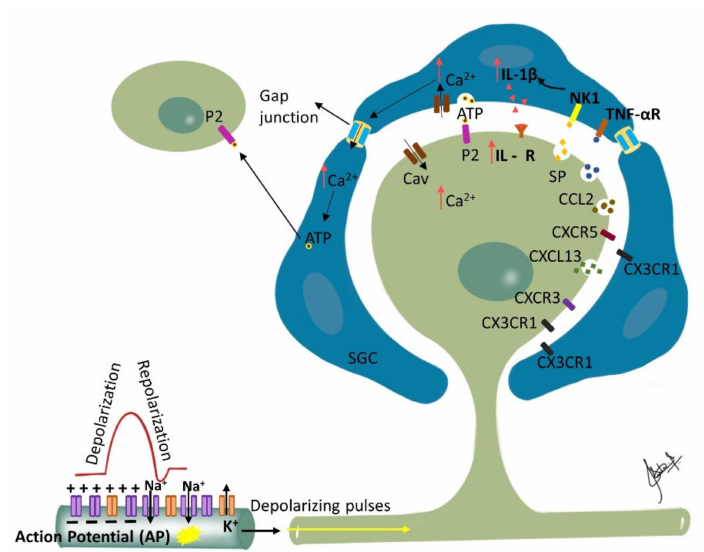
Figure 2. Ganglionic Sensitization: Changes associated with trigeminal nerve injury or inflammation lead to alterations in the cell bodies in the trigeminal ganglion (TG) that start to release pronociceptive substances. Satellite glial cells (SGC) surrounding the TG become activated in the presence of periph- eral inflammation that leads to enhanced production and subsequent activation of neurokinin 1 (NK1) receptors with the SP released from the TG nociceptor. Activated SGC produce proinflammatory cytokines (IL-1 β , TNF- α ) that bind to their receptors on the nociceptor contributing to inflammatory hyperalgesia. Additionally, binding of the somatically released ATP to their corresponding purinergic receptors on SGC leads to increase in intracellular calcium ion concentration which propagates through gap junctions inducing release of ATP by neighboring SGC. The released ATP then binds to purinergic receptors (P2) on neighboring neurons not directly affected by the injury, and affects their excitability. Additionally, released chemokines such as CXCL13 can contribute to neuropathic pain via CXCR5/ERK mediated proinflammatory cytokine production. Furthermore, CXCL10 acts on CXCR3 to induce ERK and AKT activation in TG neurons and contributes to the maintenance of trigeminal neuropathic